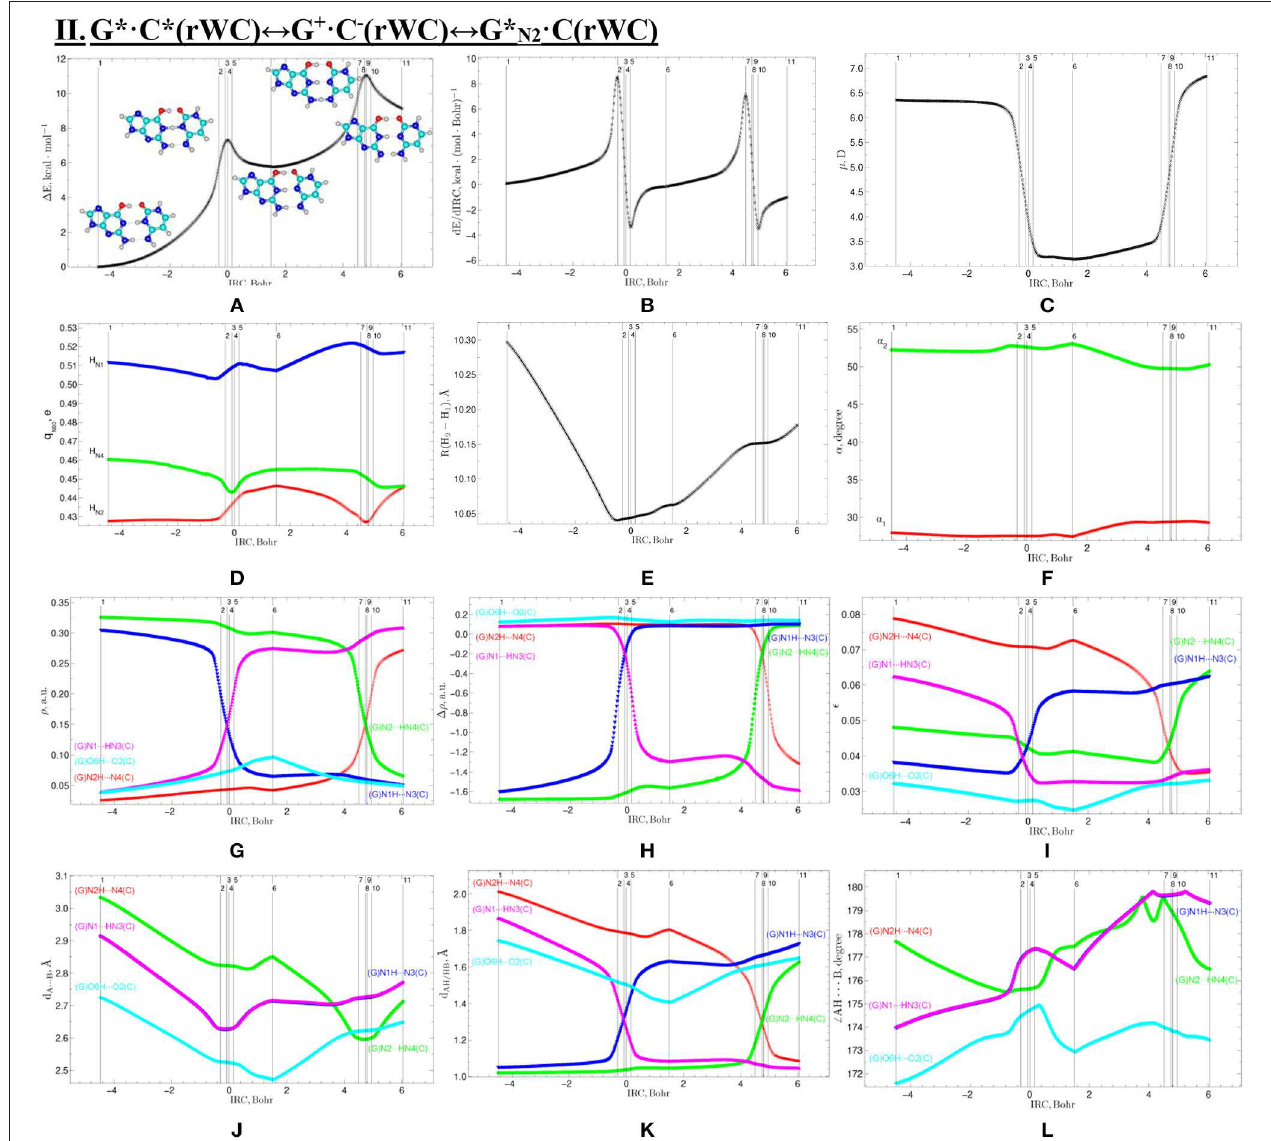
FIGURE 5 | Profiles of physico-chemical parameters of the investigated II. G* at the B3LYP/6-311